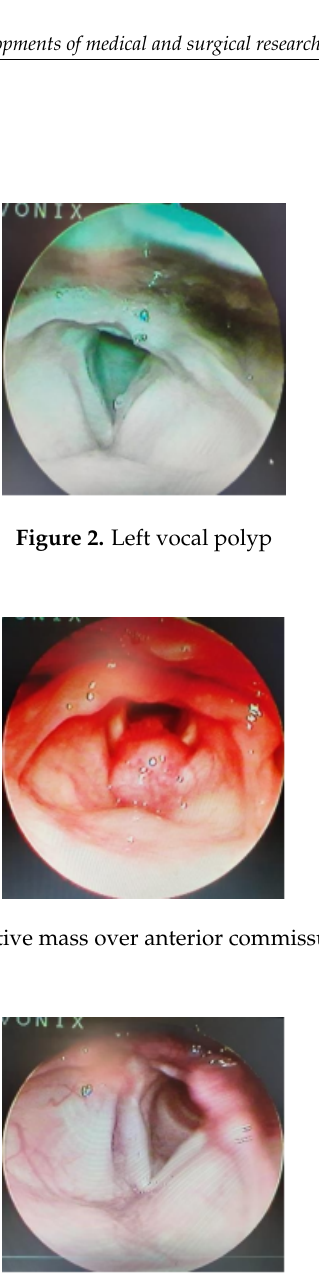
Figure 4. Left SLN palsy- bowing of right Left vocal cord seen